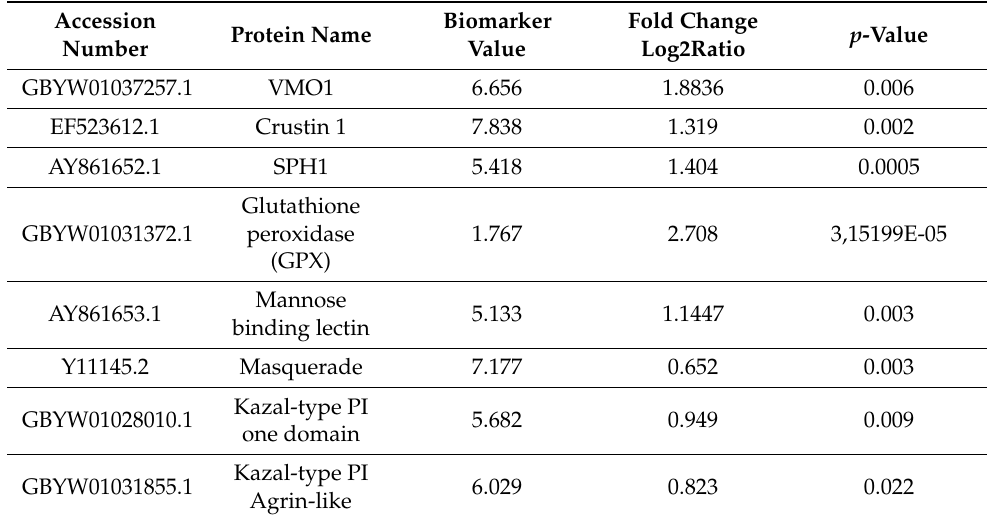
Table 2. “Biomarkers” after saline injection. Biomarker value is calculated as the multipli- cation of abundance (mean for the treatment) with the fold change as Log2ratio).